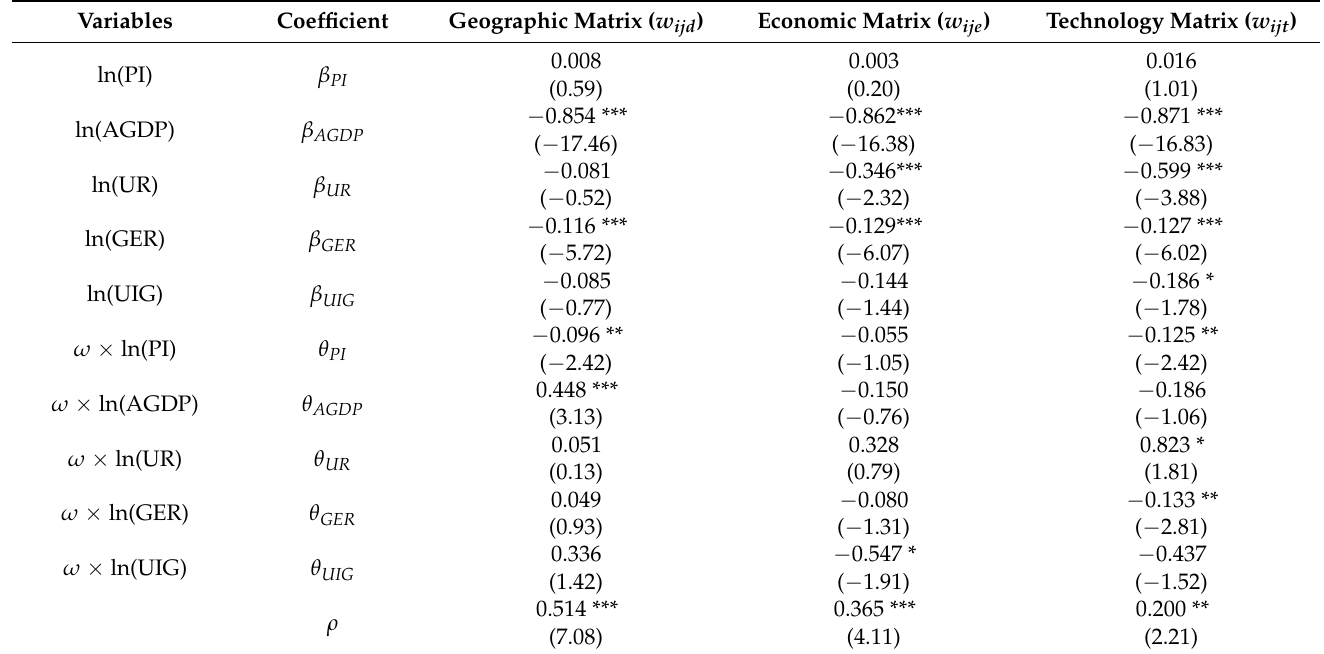
Table 6. Estimation results of the SDM model under three weight